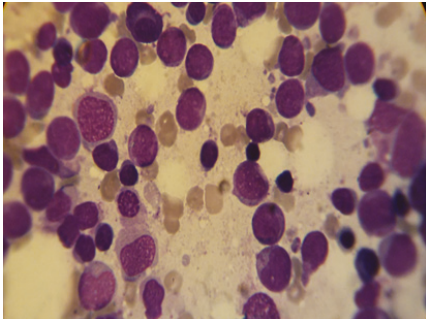
Figure 3: Bone marrow smears at spontaneous remission (2 weeks after sepsis resolution) showed 5–10% cellularity including sufficient megakaryocytes, myeloid and elytroid cells being in various matu- ration phases, and no blast.